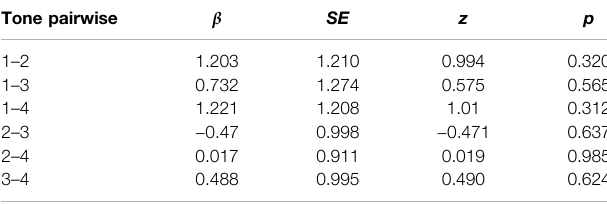
TABLE 6 | Tone comparison results under the condition of lateral.